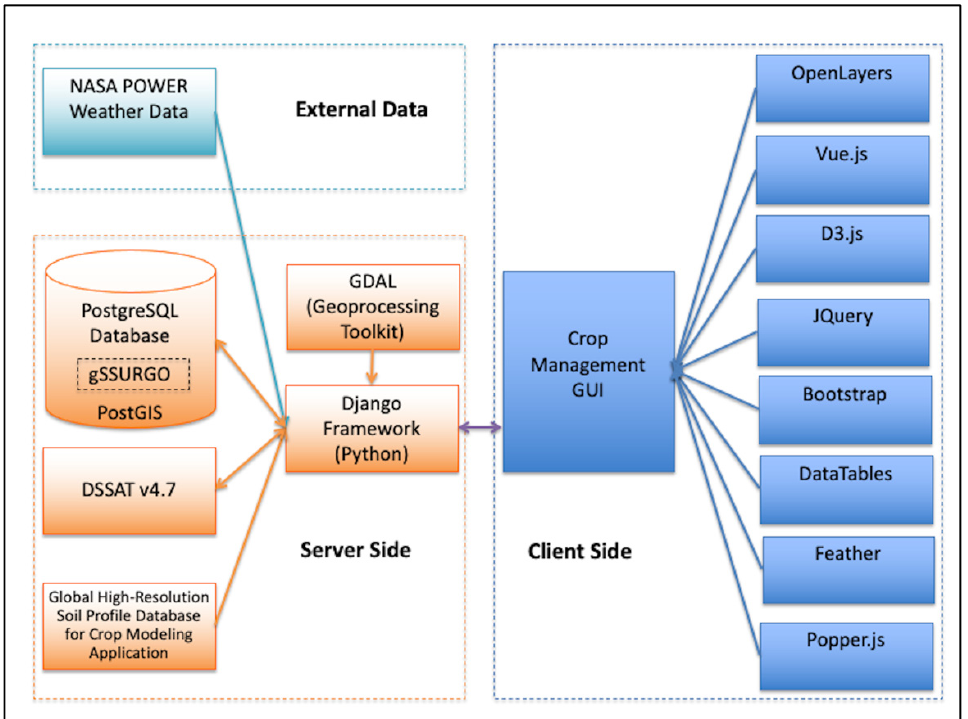
Figure 1. Architecture of FARMs implemented in the UC Davis Cyber-infrastructure for sustainable water management in agriculture (CISWMA).